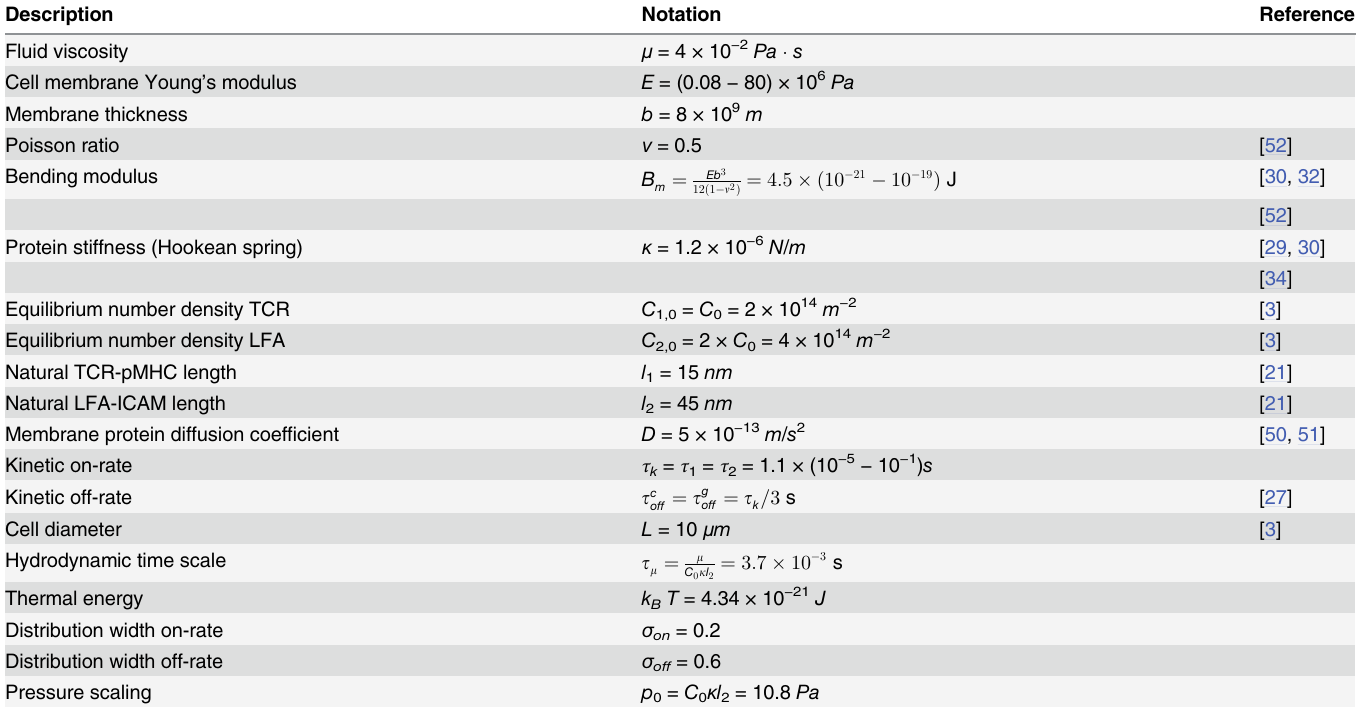
Table 1. Description of the material parameters that appear in Eqs 1 –